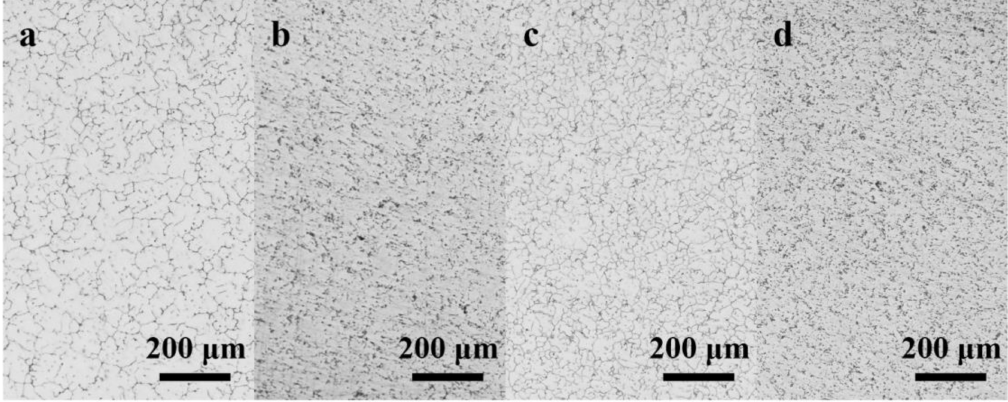
Figure 4. Optical microstructure of Mg (100 − 7x) Zn 6x Y x alloys: ( a ) as-cast Alloy 3; ( b ) extruded Alloy 3; ( c ) as-cast Alloy 4; ( d ) extruded Alloy 4.